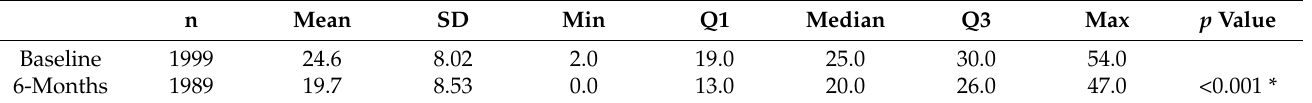
Table 3. sNLQ total scores from baseline to 6-months **.